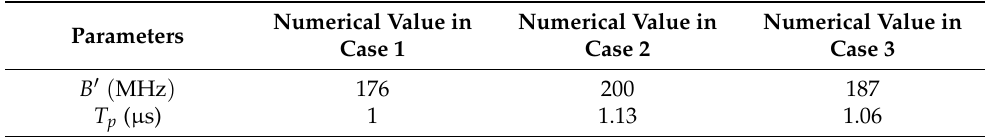
Table 3. Anti-jamming simulation parameters in range domain with three different anti-jamming